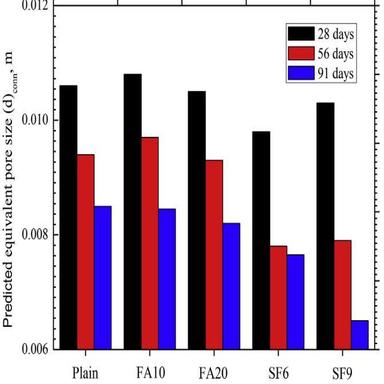
Predicted idealized equivalent pore diameters from the circuit model.